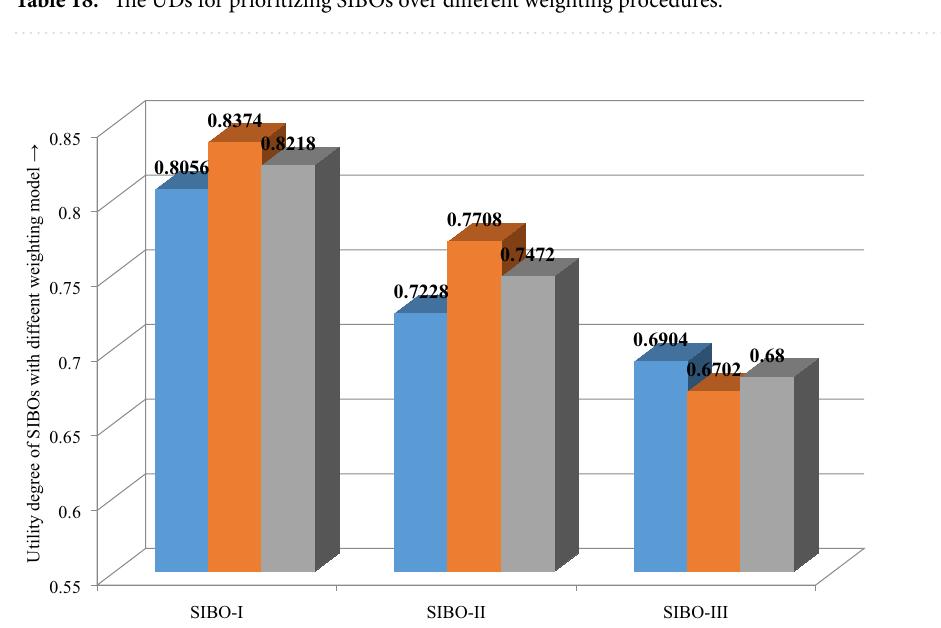
Table 18. The UDs for prioritizing SIBOs over different weighting procedures.